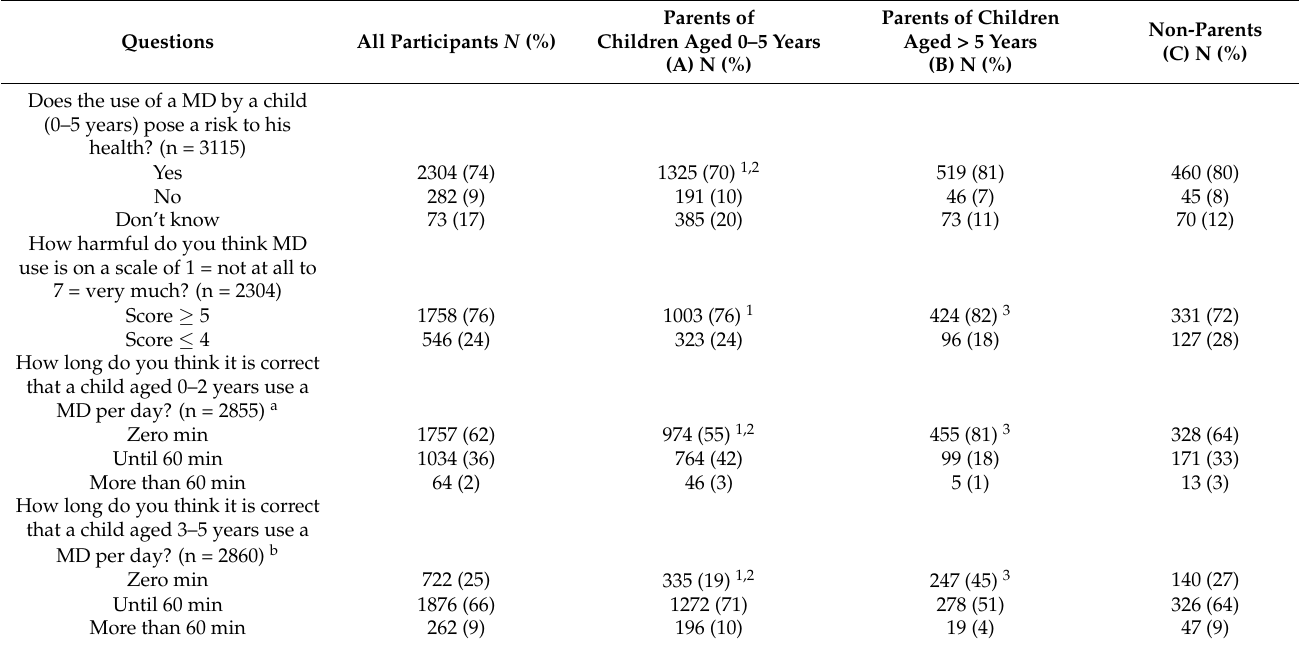
Table 2. Comparison of parents and non-parents regarding risk perception and opinions on mobile devices (MDs) use by children aged 0–5